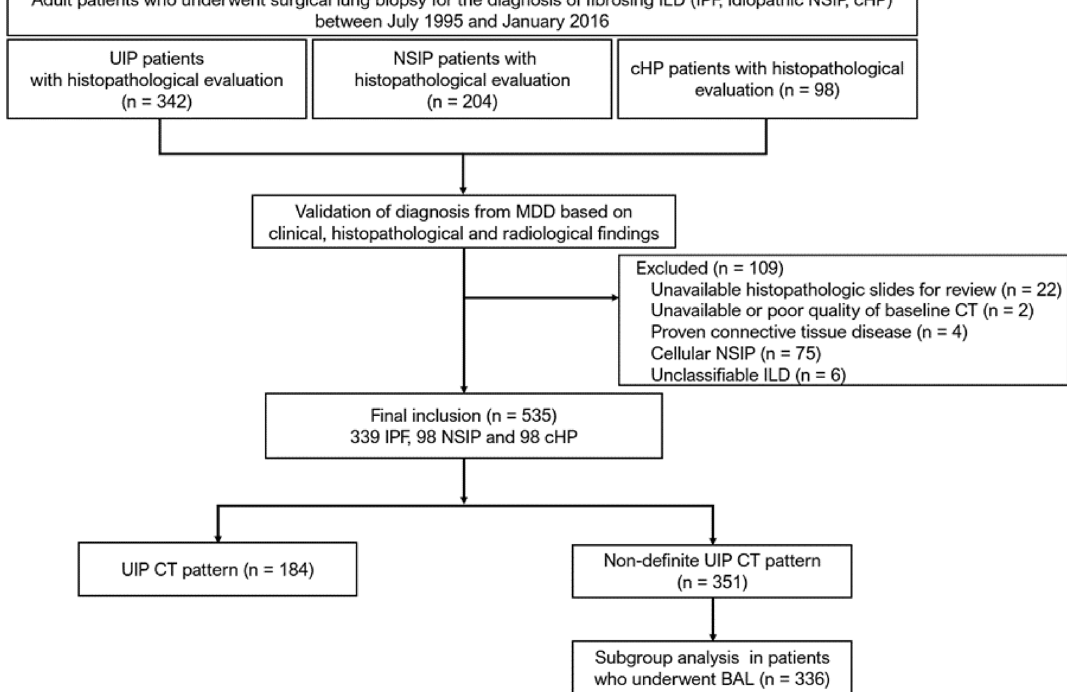
Figure 1. Flow chart of patient inclusion. ILD interstitial lung disease; IPF idiopathic pulmonary fibrosis; UIP usual interstitial pneumonia; NSIP nonspecific interstitial pneumonia; cHP chronic hypersensitivity pneumonitis; MDD multidisciplinary discussion; BAL bronchoalveolar